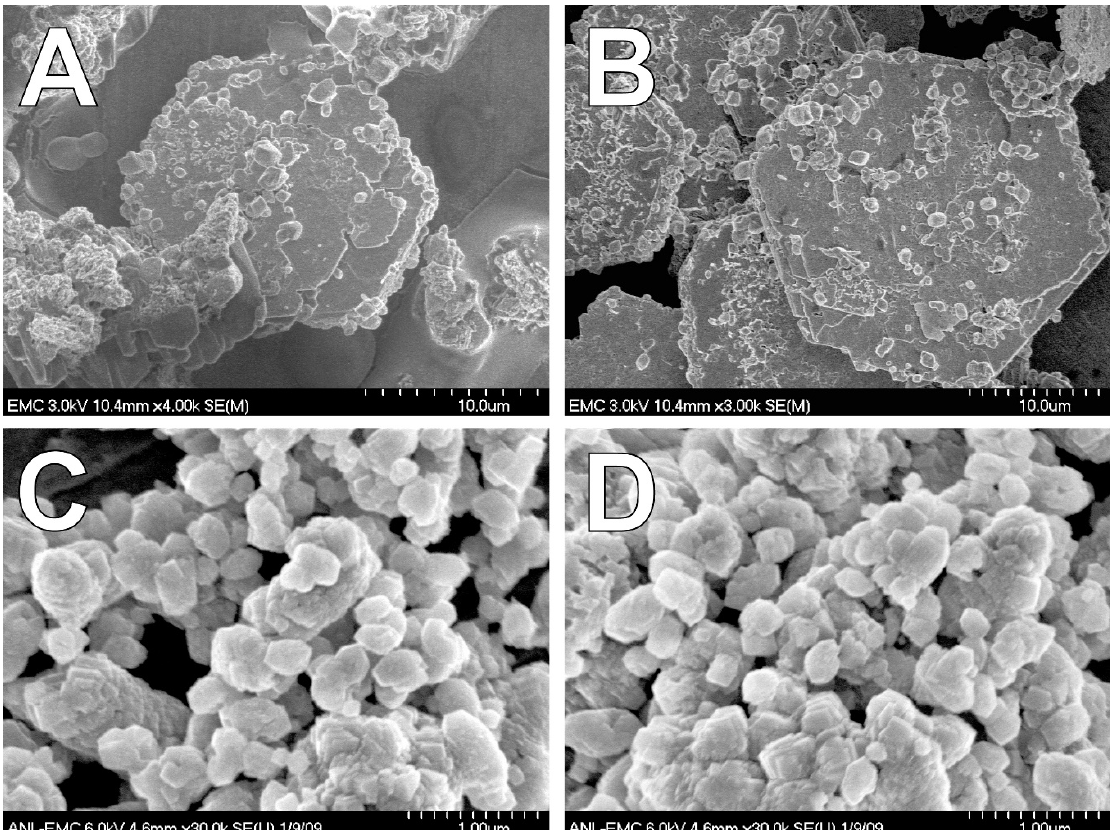
Figure 10. pXRD analysis of the solids in the systems with N -acetylglucosamine (NAG) as the electron donor amended with chloride ( left ) or sulfate ( right ).